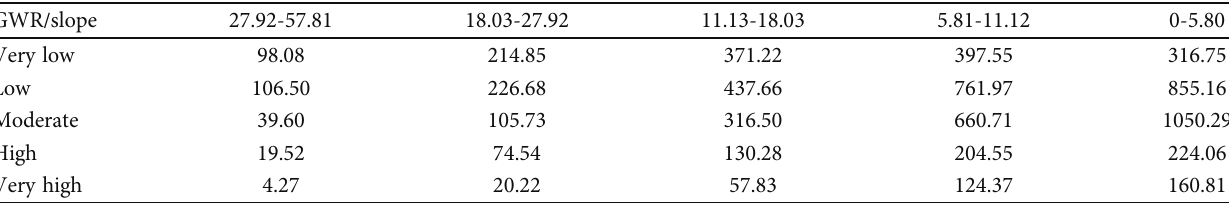
Table 11: Cross-tabulation between GWR and slope.